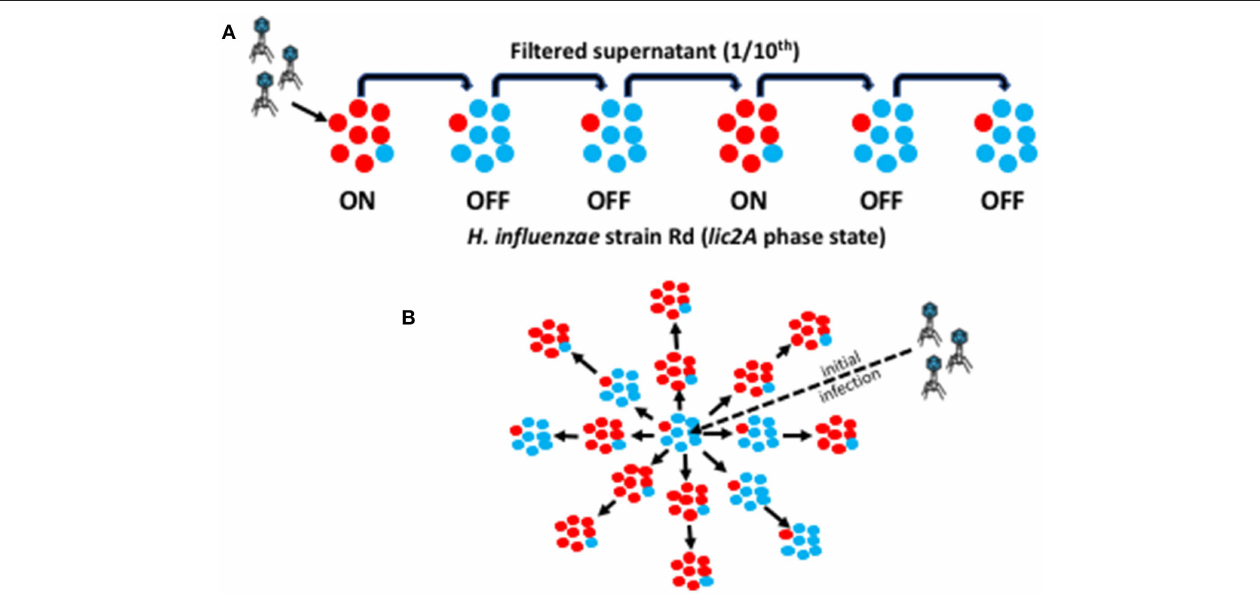
FIGURE 1 | Graphic representation of the linear and spatial oscillating prey assays. This diagram illustrates the methodology for experimental simulation of phage HP1c1 transmission through a linear or spatial meta-population structure. Red circles represent a phage-susceptible Rd 30S cell ( lic2A ON) while blue circles represent a phage-resistant Rd 30R cell ( lic2A OFF). An ON population (labeled as ON in A ) is, therefore, composed mainly of lic2A ON cells plus a small number of lic2A OFF cells generated by PV during growth of the population with the converse for an OFF population (as indicated by variants present within each sub-population). (A) Linear cycling assay for a R66 population structure consisting of one ON/phage-susceptible for every two OFF/phage-resistant sub-populations. Initially, phage are added to an exponential ON phase culture of the bacteria to a final MOI of 0.01 (i.e., ∼ 1 × 10 6 PFU/mL). After incubation of phage with the host bacteria at 37 ◦ C for 50min, allowing for one viral replicative cycle, the supernatant is harvested and passed through a 0.22 µ m filter. An aliquot of 600 µ L of filtered culture-suspension is transferred to 5.4mL (producing a 10-fold dilution of the phage) of a fresh culture of the OFF phase variant. This cycling protocol is then repeated multiple times for a linear pattern of ON and OFF sub-populations. (B) Spatial cycling assay for a 66% ON population structure. This assay is performed in a microtiter plate format where wells containing ON or OFF phase-variant sub-populations are randomly distributed across the test area. The ratio of ON:OFF wells describes the structure of the meta-population. We depict an S66 meta-population consisting of 6 OFF/phage-resistant and 11 ON/phage-susceptible sub-populations. The assay is performed in a similar manner to the linear assay except that a reduced bacterial culture volume (i.e., 300 µ L) is utilized and passage is to each adjacent